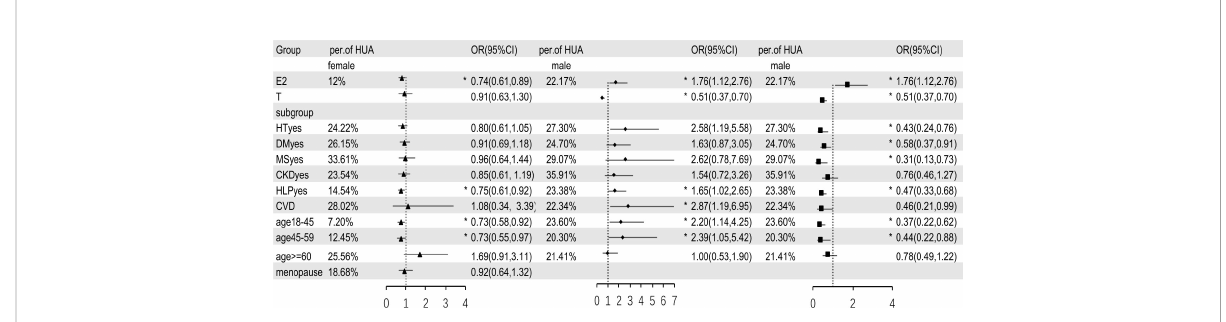
FIGURE 3 Multivariable logistic regression analysis between sex hormones and HUA, after adjusting for variables (except for the grouped variables) such as age, BMI, WC, HT, DM, MS, CKD, CVD, HLP, eth, PA and alcohol drinking. E2, estradiol; T, testosterone; HT, hypertension; DM, diabetes mellitus; MS, metabolic syndrome; CKD, chronic kidney disease; HLP, hyperlipidemia; CVD, cardiovascular disease; eth, ethnic; PA, physical activities; per of HUA, percentage of hyperuricemia; HT/DM/MS/CKD/HLP/CVDyes means people who have a history of hypertension/diabetes mellitus/